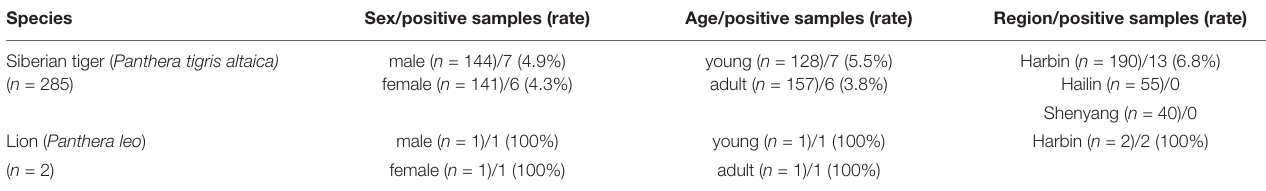
TABLE 1 | Information of FPV positive samples, including the number and positive rate by species, sex, age, and region. Species Sex/positive samples (rate) Age/positive samples (rate)